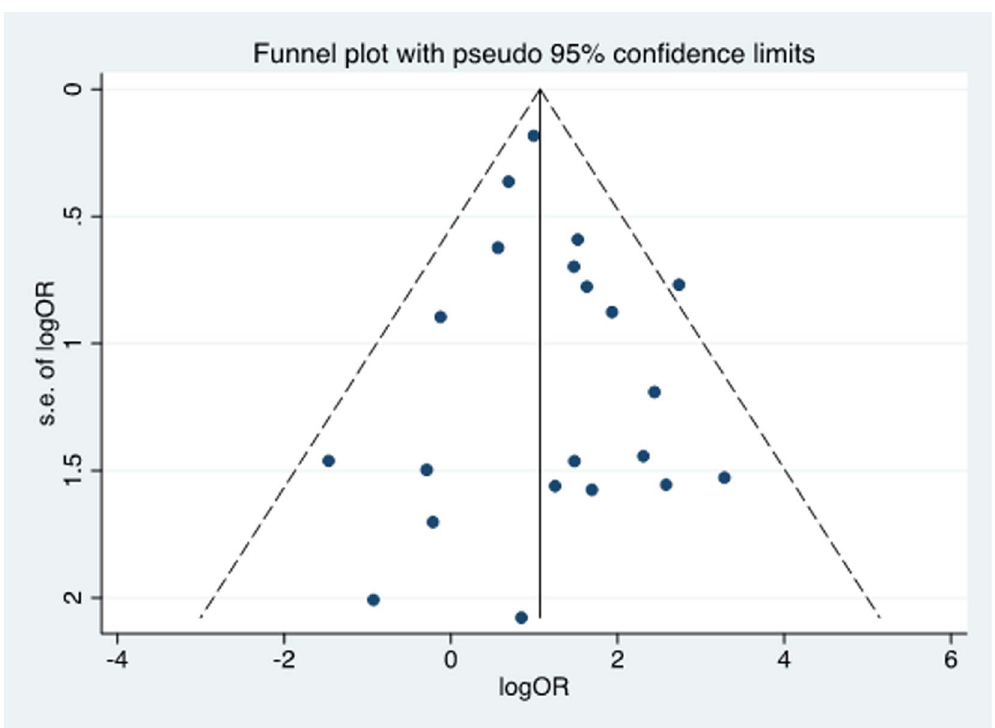
Figure 5. Funnel plot for analysis results of publication bias.